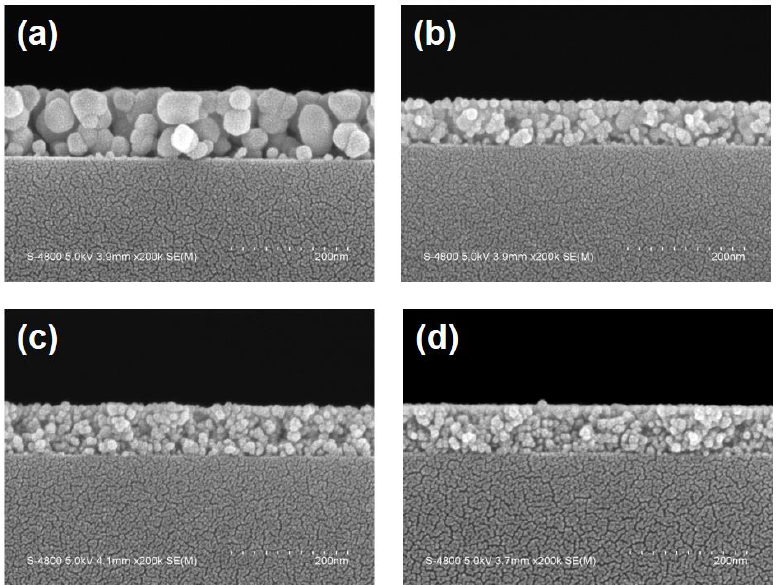
Figure 2. Cross-sectional field-emission scanning electron microscope (FE-SEM) micrographs of sol-gel derived ZnO-based thin films on glass substrates: ( a ) ZnO, ( b ) ZnO:Al, ( c ) ZnO:Al-1% B and ( d ) ZnO:Al-2% B thin film samples.